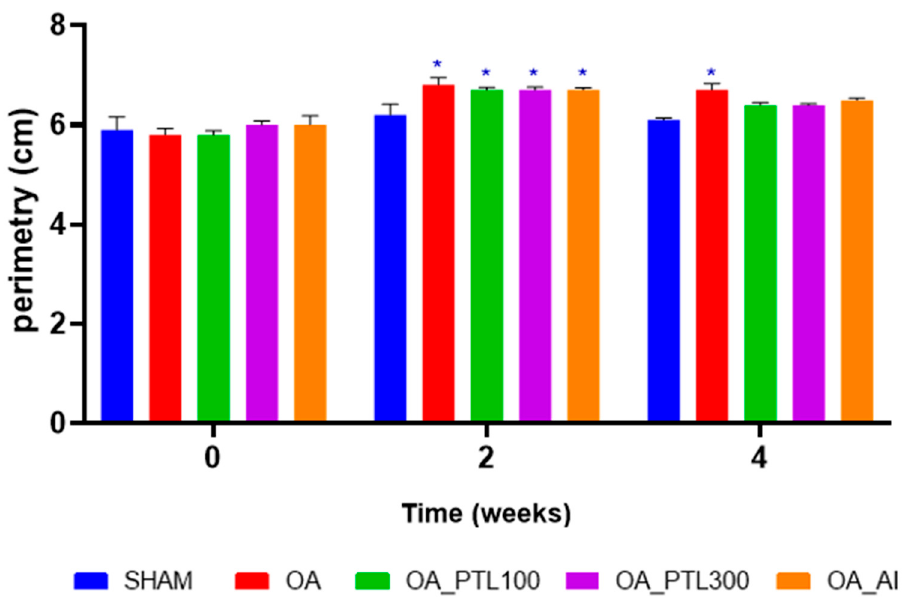
Figure 5. Assessment of knee perimeter throughout the experimental period. Symbols are colored according to their respective experimental group. Di ff erences between the sham, OA, OA_PtL100, OA_PtL300, and OA_AI groups were assessed using a two-way ANOVA. Results are expressed as mean ± SEM. * p < 0.05 n SHAM = 4; n OA = 4; n OA_PTL100 = 5; n OA_PTL300 = 5; n OA_AI = 5) (SHAM—control animals that underwent all surgical procedures but were not induced OA; OA—osteoarthritic animals; OA_PTL100—osteoarthritic animals that from week two were treated with a concentration of 100 mg/kg of Pterospartum tridentatum extract; OA_PTL300—osteoarthritic animals that from week two were treated with a concentration of 300 mg/kg of Pterospartum tridentatum extract; OA_AI—osteoarthritic animals that from week two were treated with a commercial nonsteroidal anti-inflammatory drug).